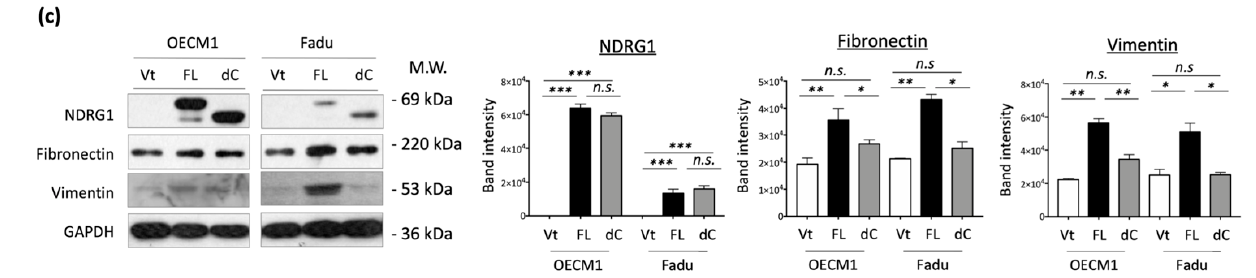
Figure 5. NDRG1-3R motif is critical for cellular motility. ( a ) Deletion of the C-terminal domain signif- icantly attenuated NDRG1-induced cell migration. After transfection of the NDRG1-FL, NDRG1-dC, or the vector plasmid into HNC cells, the cells were subjected to wound healing migration analysis. ( b ) Deletion of the C-terminal domain significantly inhibited NDRG1-induced cell invasion. After transfection of the NDRG1-FL, NDRG1-dC, or the vector plasmid into HNC cells, the cells were sub- jected to Matrigel invasion assay. ( c ) Deletion of the C-terminal domain suppressed NDRG1-induced ECM-associated molecules. After transfection of the NDRG1-FL, NDRG1-dC, or the vector plasmids into HNC cells, cellular proteins were extracted and subjected to Western blot analysis. The GAPDH was used as an internal control. All the experiments were performed three times independently and typical results were shown. The error bars shown in the relevant figures indicate the standard deviation of the quantification results. (* p < 0.05; ** p < 0.01; *** p < 0.001; n.s., no significance; t -test).